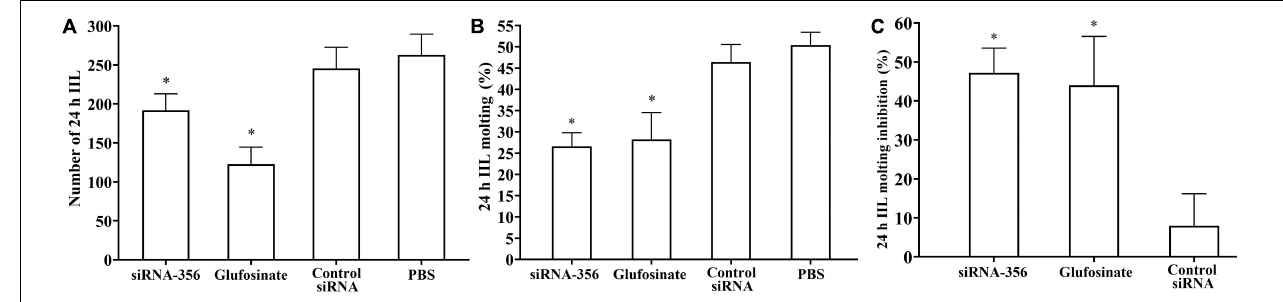
FIGURE 11 | Suppression of siRNA-356 on larval infectivity and molting. (A) Intestinal worm burden of the intestinal infectious larvae (IIL) recovered at 24 h post-infection ( n = 10). (B) Molting rate of 24-h IIL ( n = 50). (C) siRNA-356 inhibited IIL molting. ∗ P < 0.05 compared to the control siRNA and phosphate-buffered saline